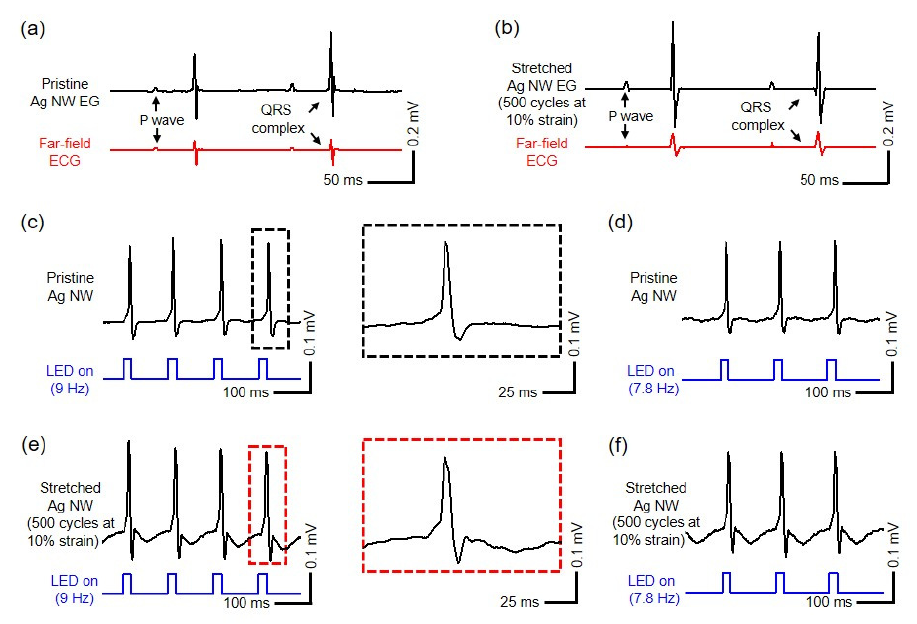
Figure 6. Electrophysiological recordings of heart rhythm from the reference electrode and Ag NW microelectrodes ( a ) before and ( b ) after been stretched. EG recording from the pristine Ag NW microelectrodes under optogenetic pacing at ( c ) 9 Hz and ( d ) 7.8 Hz, respectively. A representative QRS complex under pacing is shown in ( c ) (Right). EG recording from the stretched Ag NW microelectrodes under optogenetic pacing at ( e ) 9 Hz and ( f ) 7.8 Hz, respectively. A representative QRS complex under pacing is shown in ( e ) (Right).